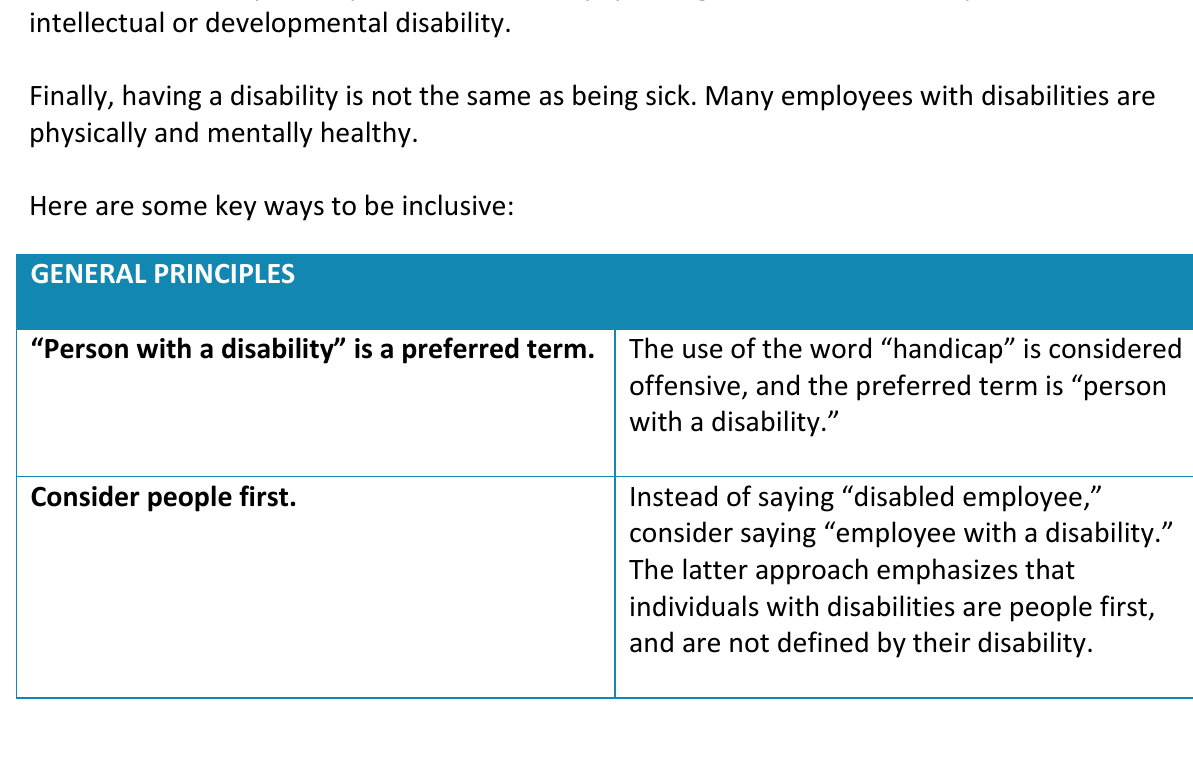
Page | 17 | Words Matter: Guidelines on Using Inclusive Language in the